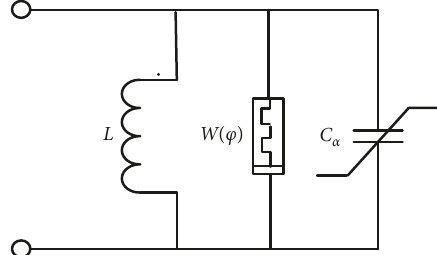
Figure 7: The memristor-inductor circuit with the parasitic fractional capacitor.